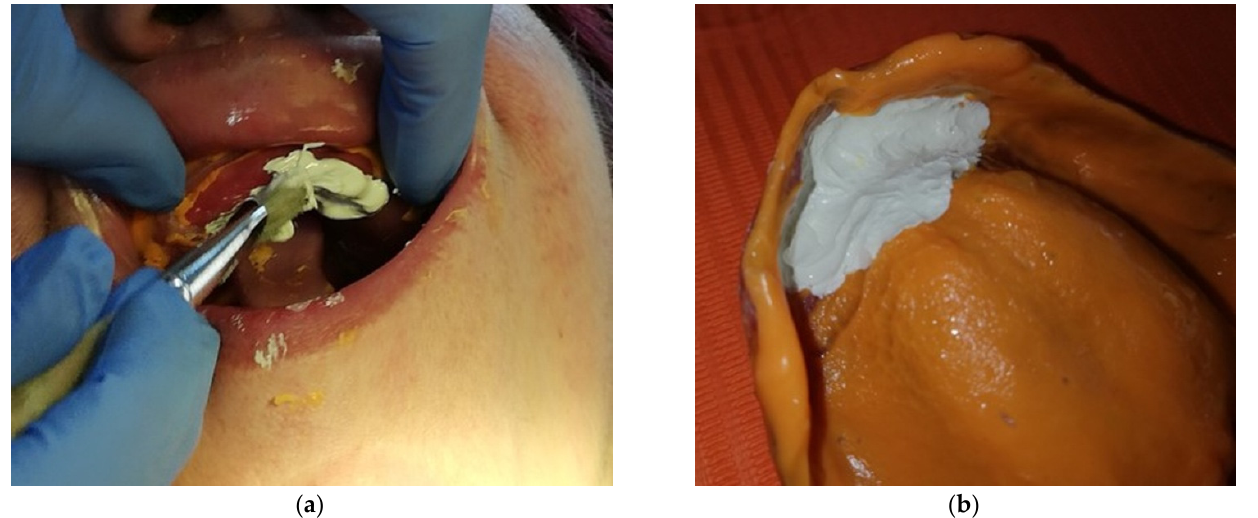
Figure 8. ( a ) flabby mucosa impression technique; ( b ) details of final impression. After establishing occlusal relationships and wax dentures try-in occlusal adaptation, the maxillary complete denture and a biodentaplast partial flexible mandible denture were applied in the oral cavity, their maintenance and stability being of good quality. (Figure 9a,b).